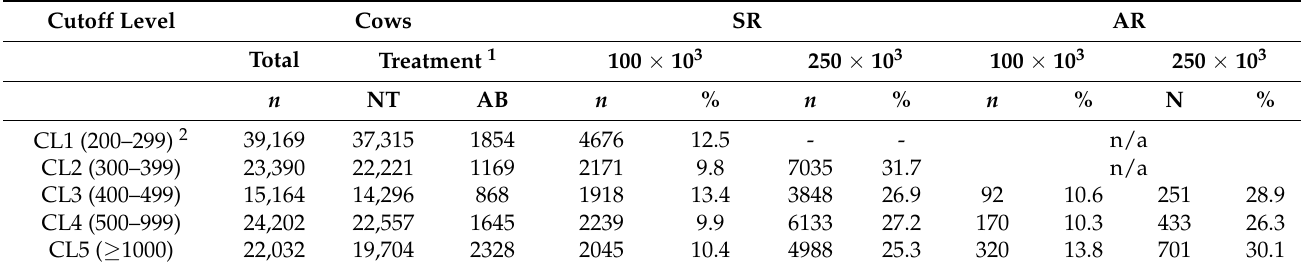
Table 2. The five independent analyses based on somatic cell count-cutoff levels for spontaneous recovery (SR) from inflammation and recovery due to antibiotic treatments (AR), with recovery set at 100 × 10 3 or 250 × 10 3 cells/mL. Cutoff Level